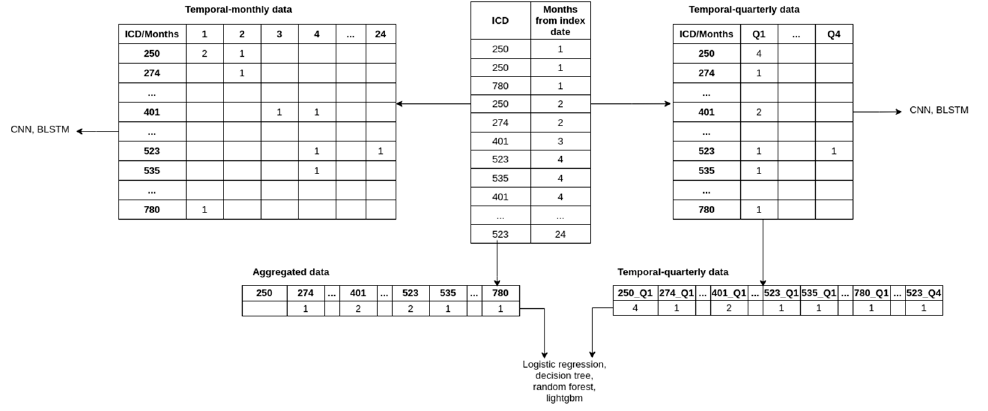
Figure 4. Example of temporal, temporal-quarterly, and aggregated data prepared from the raw data.